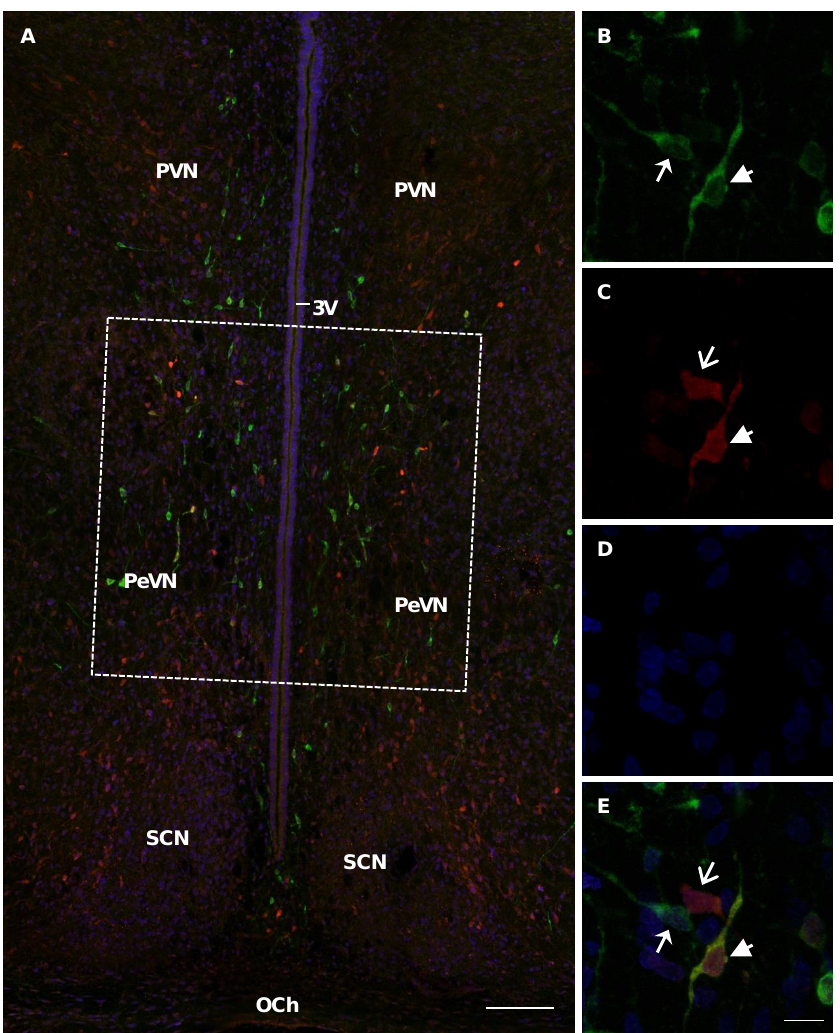
Figure 5. Confocal microscopy of the periventricular nucleus (PeVN) (frontal sections) of the rat on postnatal day 5. ( A ), general view of the PeVN (dotted frame) with neurons, immunopositive for either tyrosine hydroxylase (TH, green) or aromatic L-amino acid decarboxylase (AADC) (red). ( A , B , E ), neurons, immunopositive for TH, but immunonegative for AADC (green, arrow); ( C , E ), immunopositive for AADC, but immunonegative for TH (red, open arrow); ( B , C , E ), immunopositive for both enzymes (yellow, arrowhead). D, cells with nuclei stained with DAPI (blue). 3V, 3rd cerebral ventricle; OCh, optic chiasma; PVN, paraventricular nucleus; SCN, suprachiasmatic nu- cleus. Bar: ( A ) — 100 µm, ( B – E ) — 10 µm.